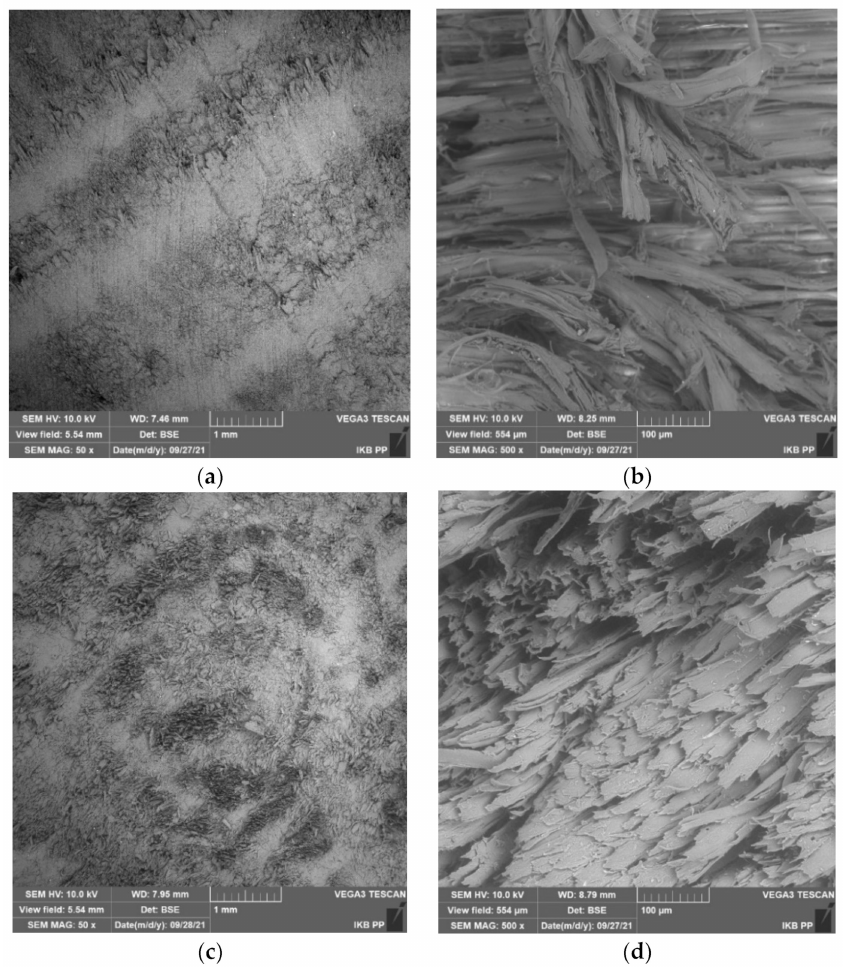
Figure 2. Structure of pine wood ( a,b ) and spruce wood ( c,d ), from one batch of sawn